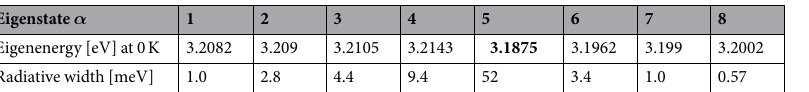
Table 1. Calculated eigenenergies at 0 K and radiative width of respective light–exciton coupled modes in a CuCl thin film with a thickness of 318